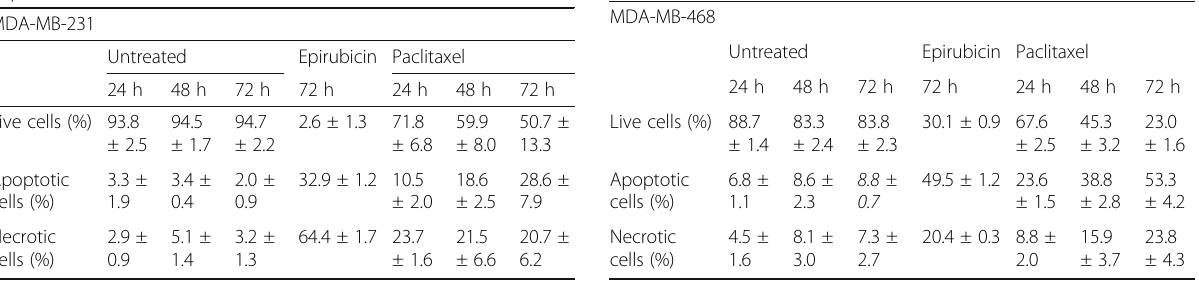
Table 3 Apoptosis analysis of MDA-MB-231(a) and MDA-MB- 468(b) cells after incubation with treatment at 10xIC 50 for 24 h, 48 h, and 72 h by flow cytometry using Annexin V/PI apoptosis assay. Results are shown as mean ± SD ( n = 3 independent